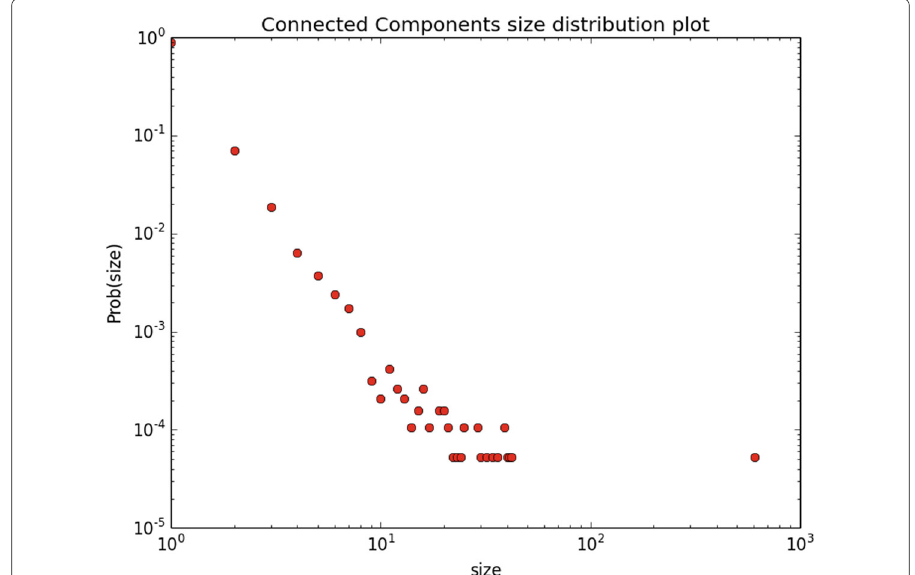
Fig. 8 Size distribution (number of nodes) of connected components in phone activity